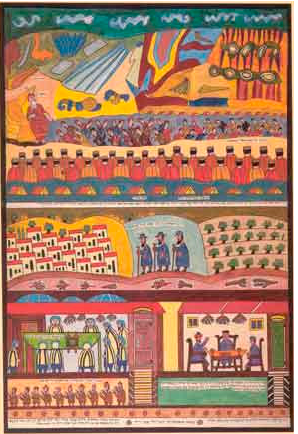
Figure 1. Shalom of Safed (Shalom Moscovitz): Sinai/Shavuot . 1969. Acrylic on Canvas (84 cm × 122 cm). Image photographed by the author from book, Images from the Bible (Overlook Press, 1980).